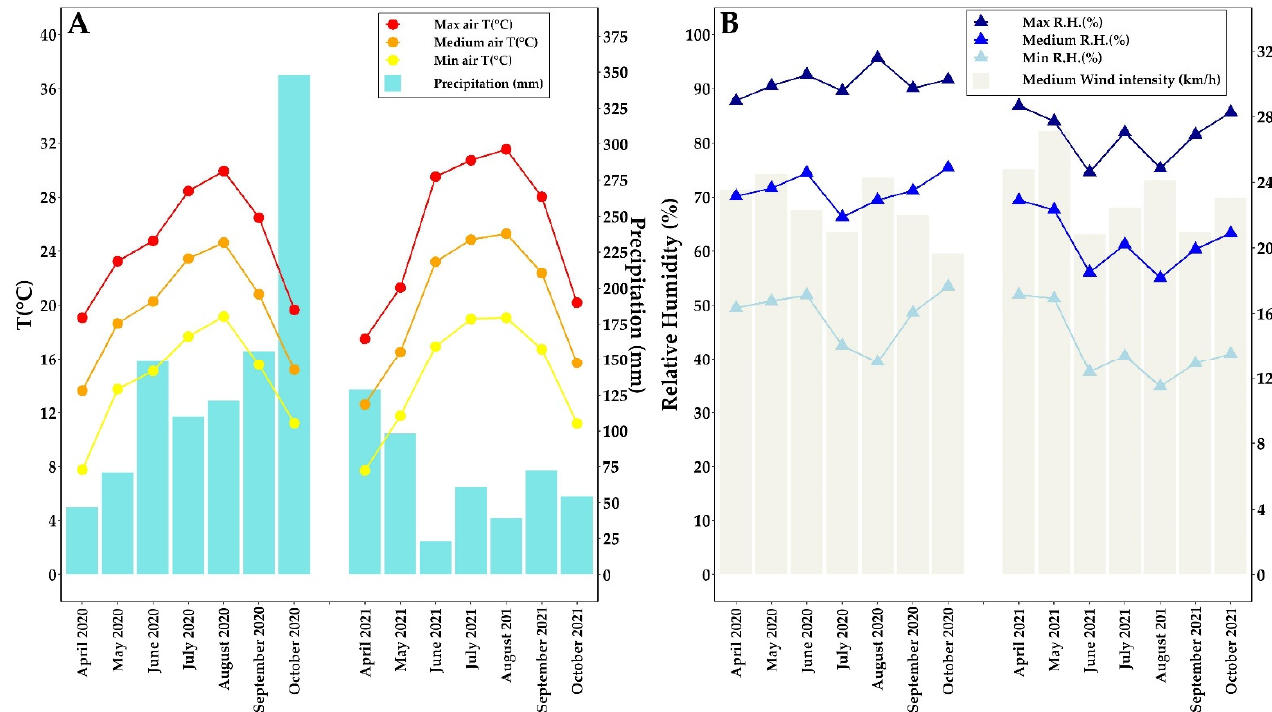
Figure 3 informed on meteorological guidelines of the area in the 2020 and 2021 growing seasons.